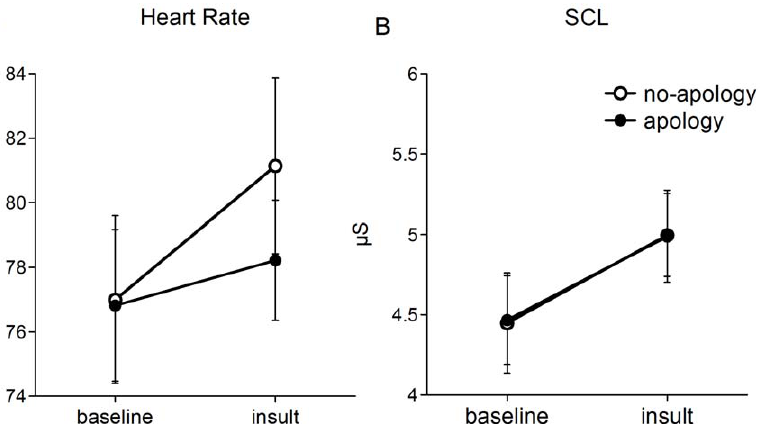
Figure 2. The results of HR (A) and SCL (B) for each group were displayed in the baseline and the insult periods. Each vertical line illustrates the standard error for each condition.